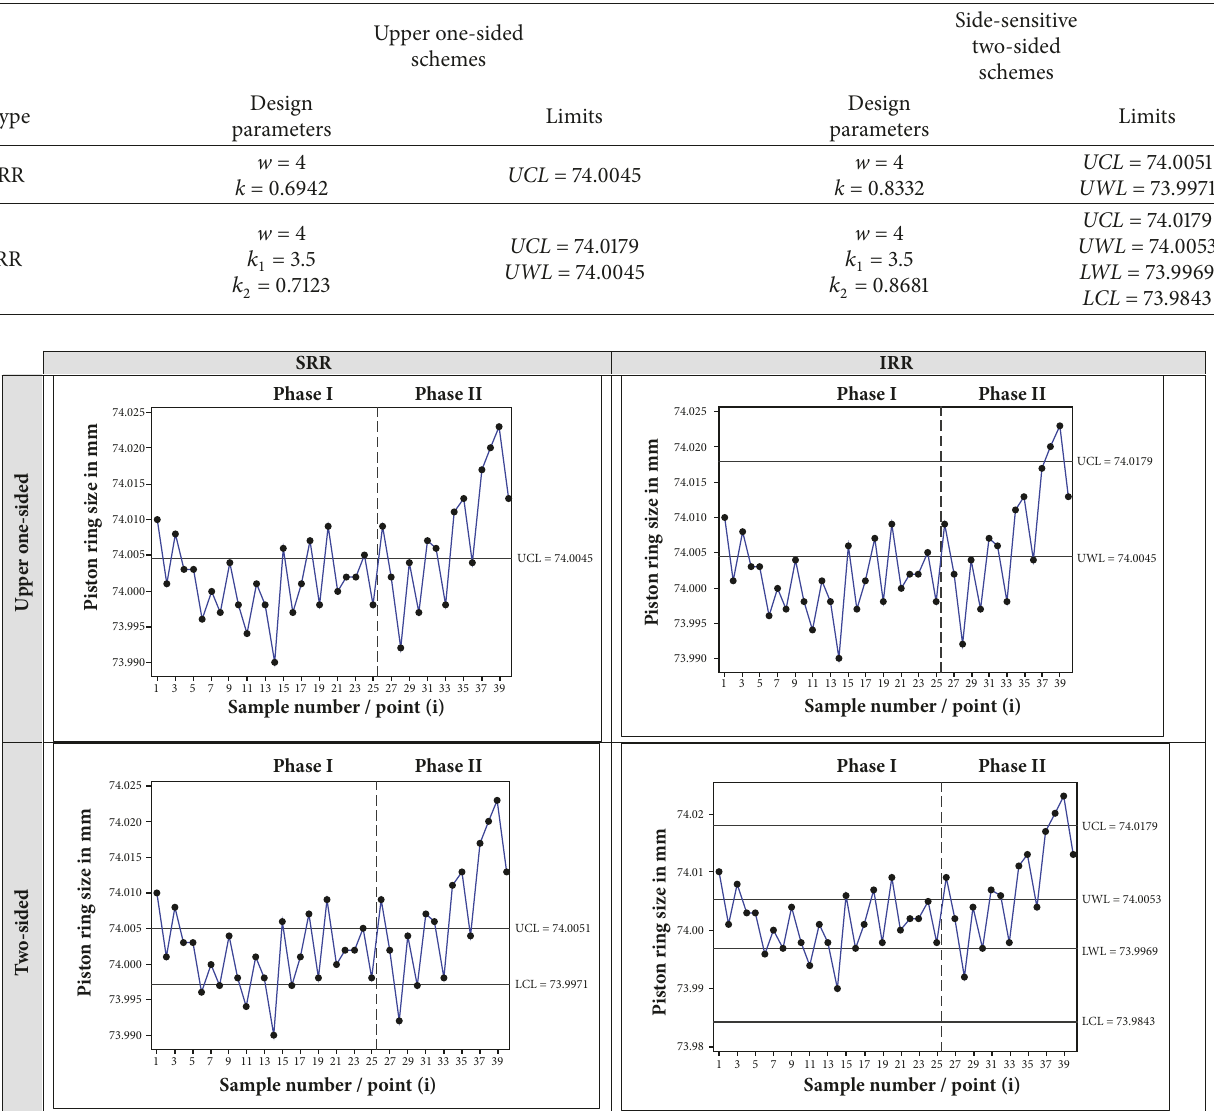
Table 7: The design parameters and limits of the piston ring data.